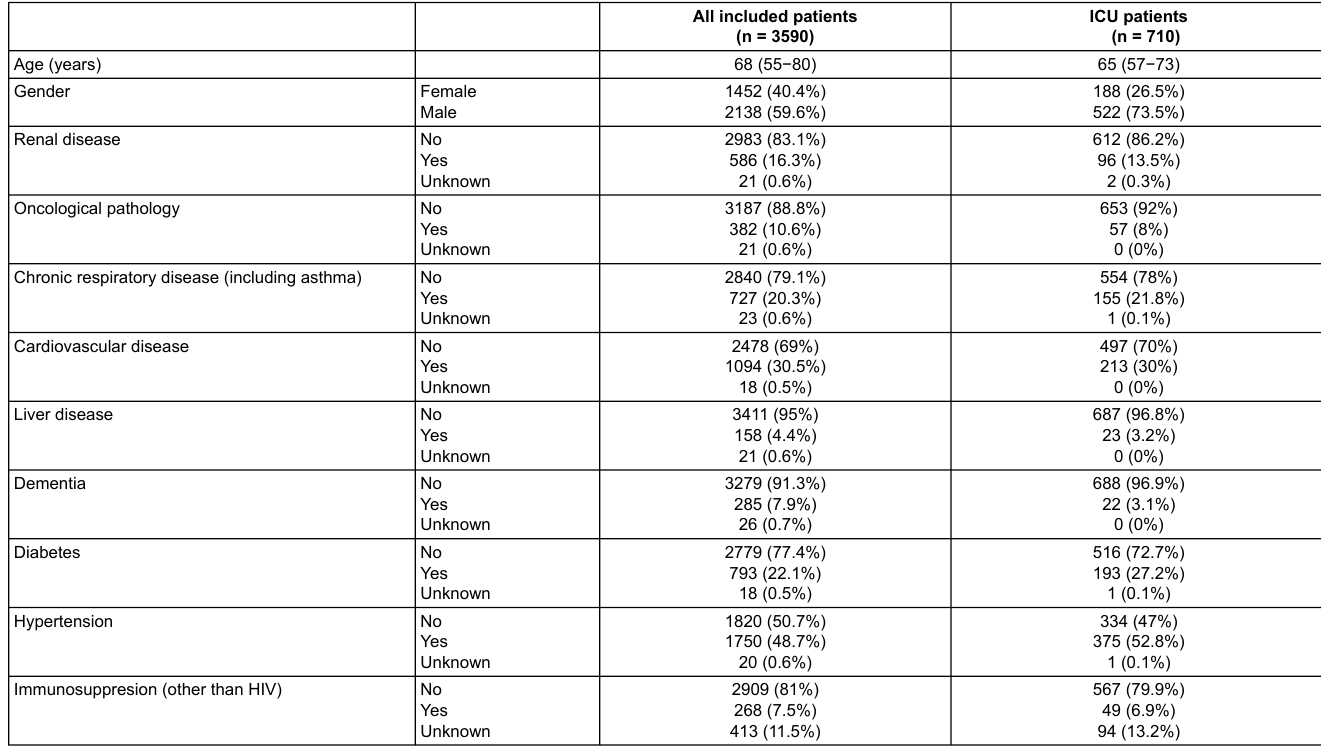
Table S3: Characteristics of patients admitted to ICU.